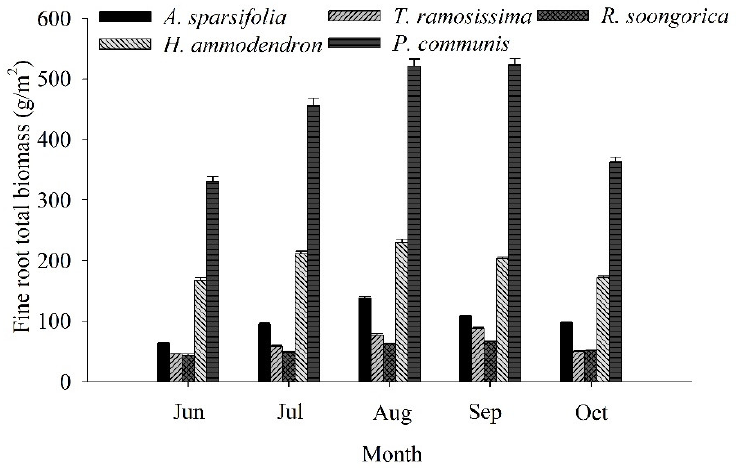
Figure 4. Seasonal fine root biomass (mean ± SD) at 0–100 cm of the five plant communities. Each month represents the average of three replicate plots.